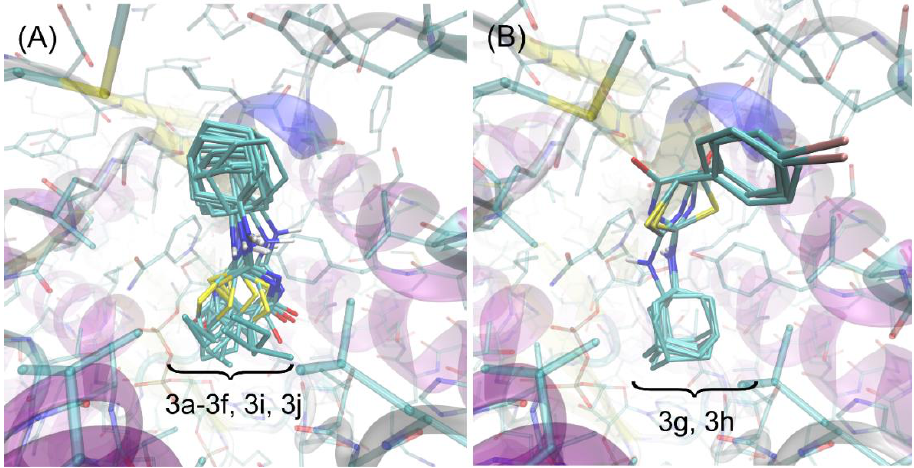
Figure 4. The superposition of poses of all ligands found during docking study. ( A ) The cluster of poses characteristic for the most energetically favorable orientations of ligands 3a – 3f , 3i , and 3j . ( B ) The alternative poses exhibited by compounds 3g and 3h (see discussion in the